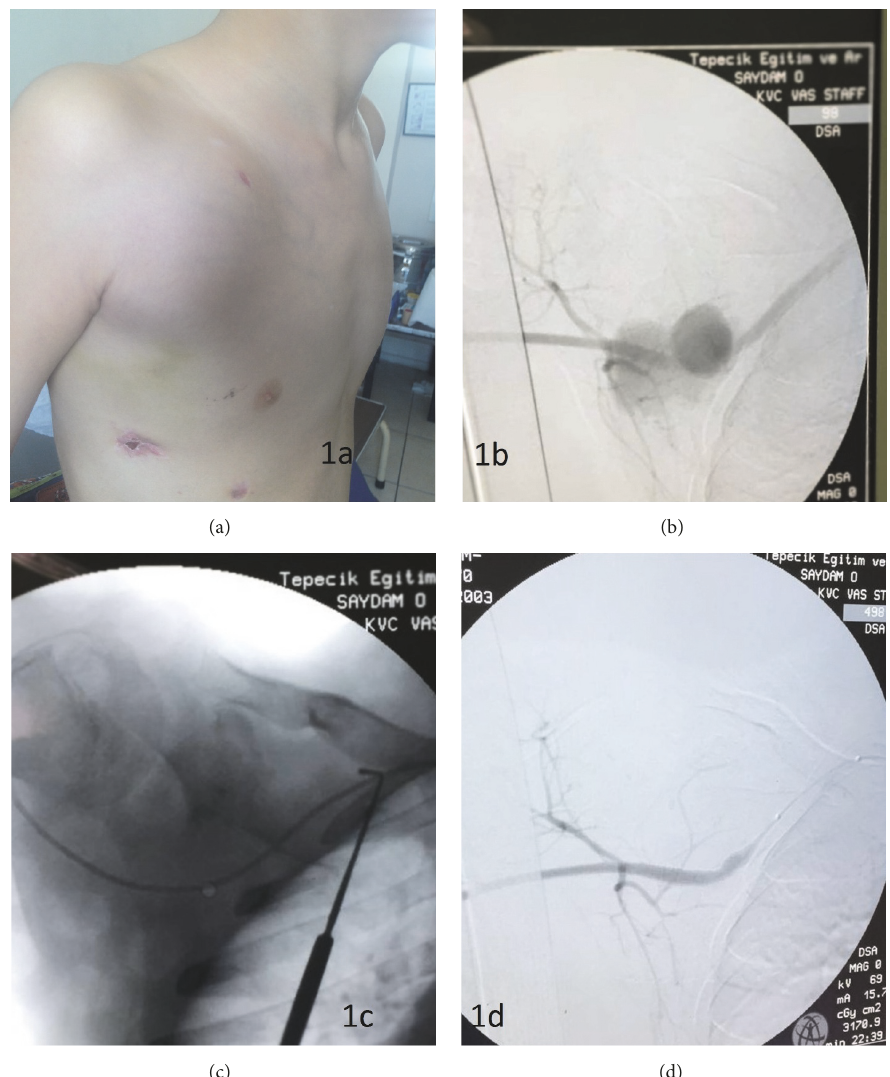
Figure 1: (a) Large subclavian pseudoaneurysm pulsatile sac with palpable trill. (b) Angiogram of pseudoaneurysm sac originated from the right subclavian artery. (c) Passing the lesion with 0.035 hydrophilic guide wire with the help of 5F straight selective multipurpose diagnostic catheter. (d) Final selective angiogram of the right subclavian artery with a complete hemostasis and preserved subclavian artery